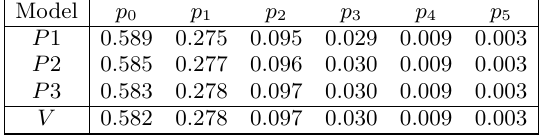
Table 1: Simulated values for p k := P [ N 1 = k ].